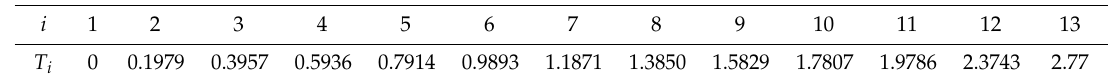
Table 2. The values of T i , i = 1,2, ... ,13.